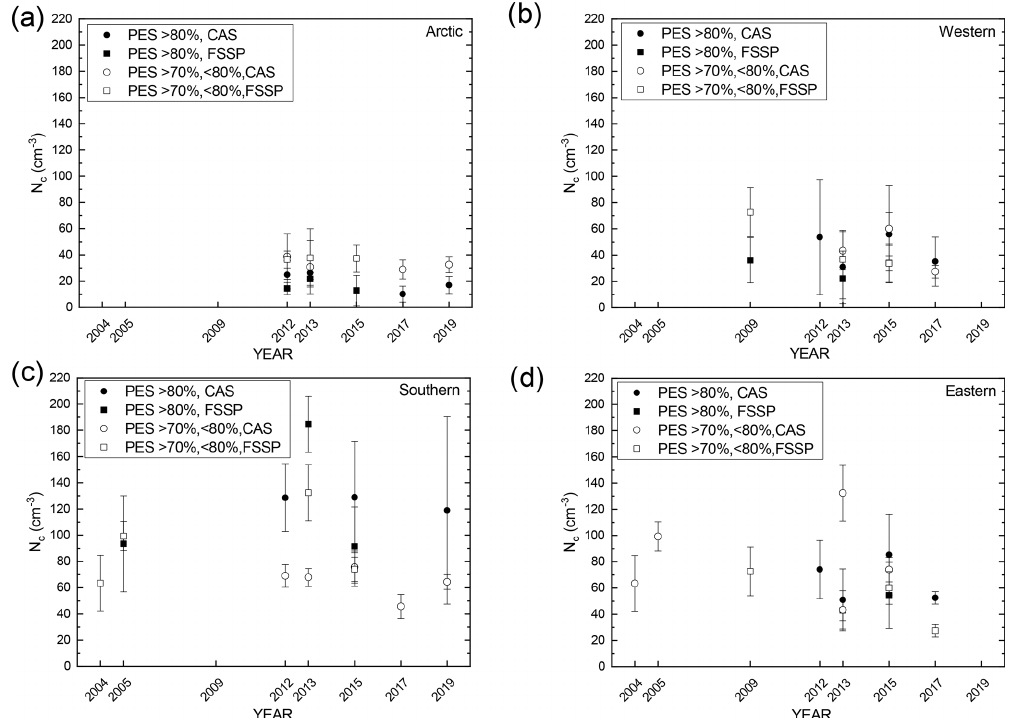
Figure 7. Cloud droplet number concentration ( N c ) for each region and single PaCE campaign measured by the cloud and aerosol spectrom- eter (CAS) and the forward-scattering spectrometer probe (FSSP) where the PES fraction was within one region > 80% (full symbols) and the PES fraction was within one region from 70% to 80% (open symbols). Error bars indicate the corresponding standard deviation.